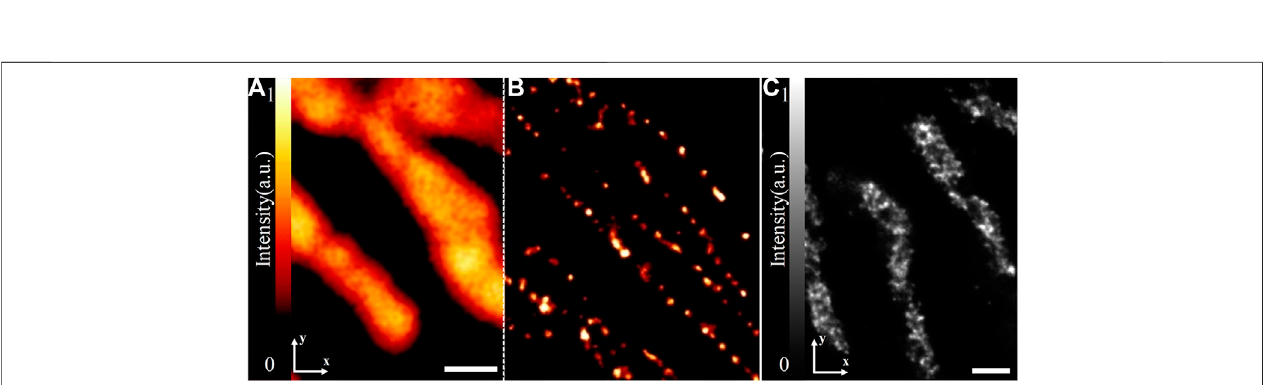
FIGURE 7 | Applications of isoSTED in 3D imaging. (A) and (B) Confocal image (A) and isoSTED image (B) of the translocase on the outer membrane of mitochondria complexes. (C) isoSTED image of mitochondrial inner membrane cristae protein complexes F1F0ATPase. There are pronounced heterogeneous cristae arrangements within individual mitochondrial tubules in which some regions are absent of cristae. Figures are modi fi ed with permission from Ref. 41. Copyright © 2009 American Chemical Society. All scale bars: 500 nm.